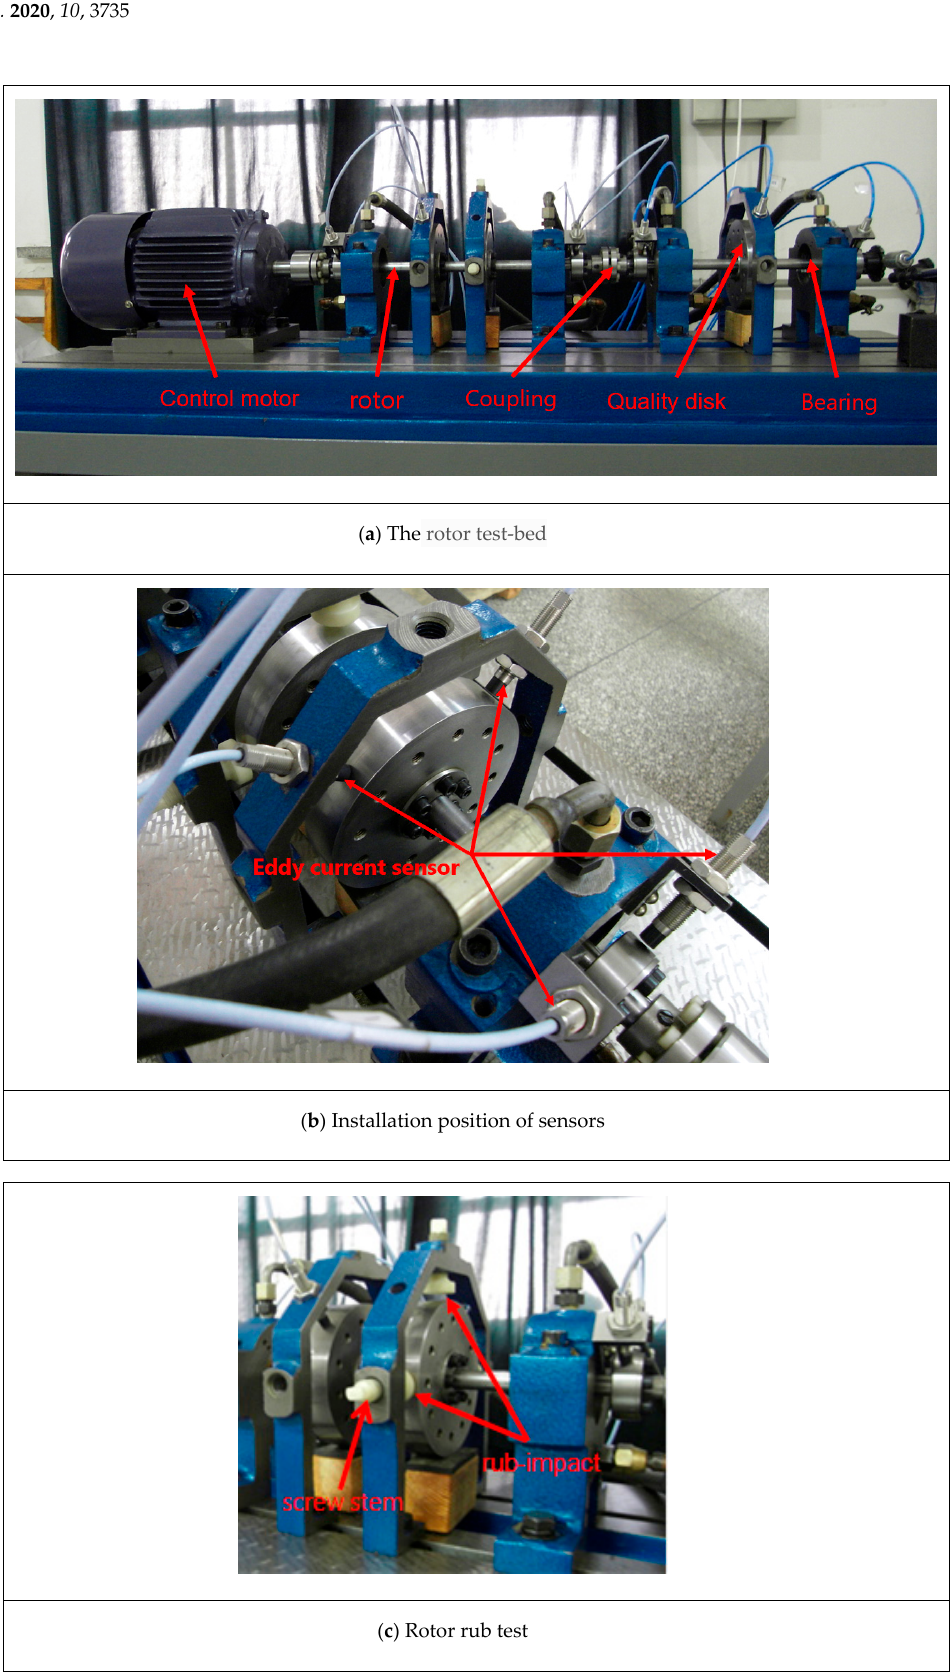
Figure 7. The two-span rotor-bearing rig.